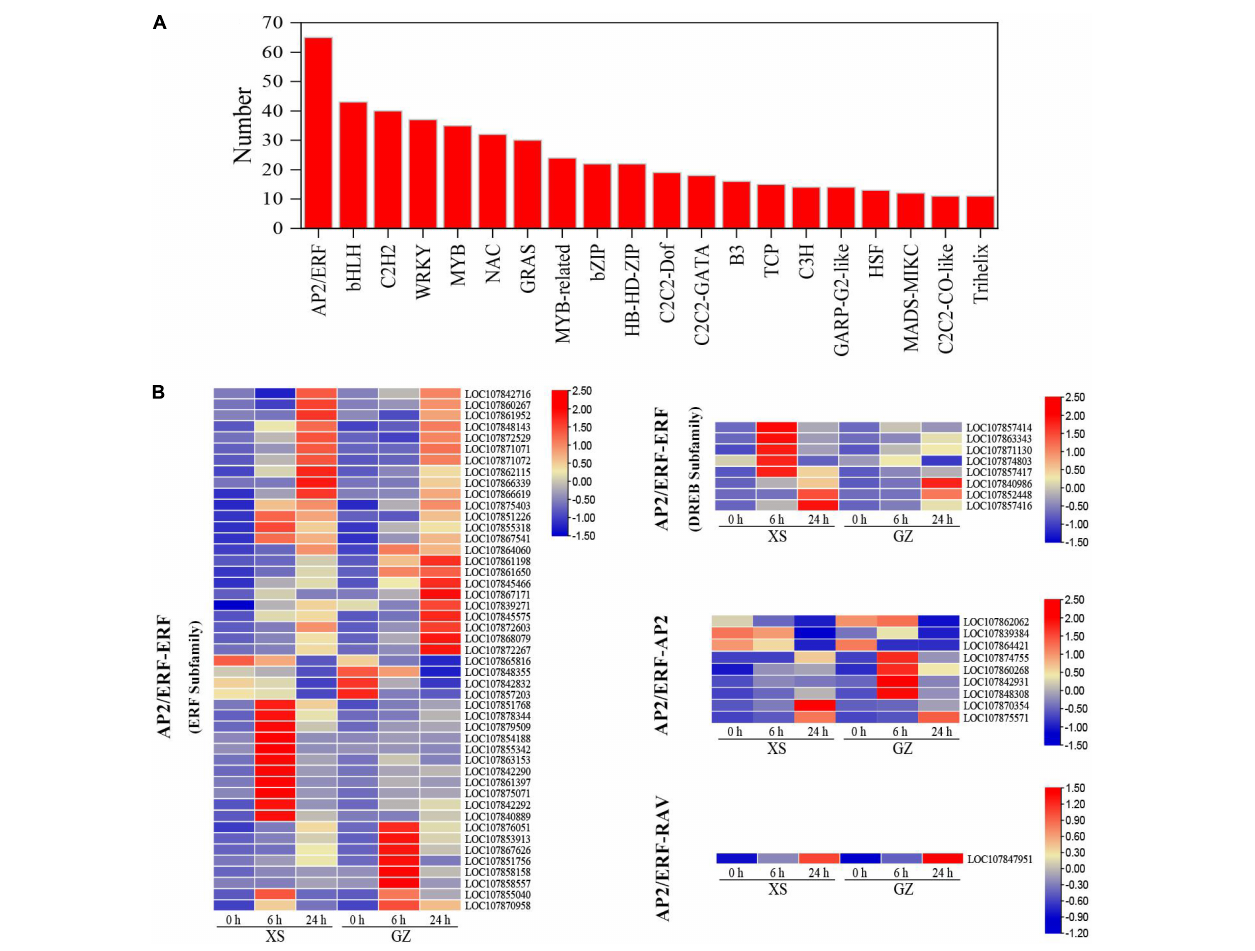
FIGURE 4 | Analysis of transcription factors (TFs) in differentially expressed genes (DEGs). (A) Top 20 transcriptome factors. (B) Classification of AP2/ERF family. Color bins represent Log10 FPKM of a